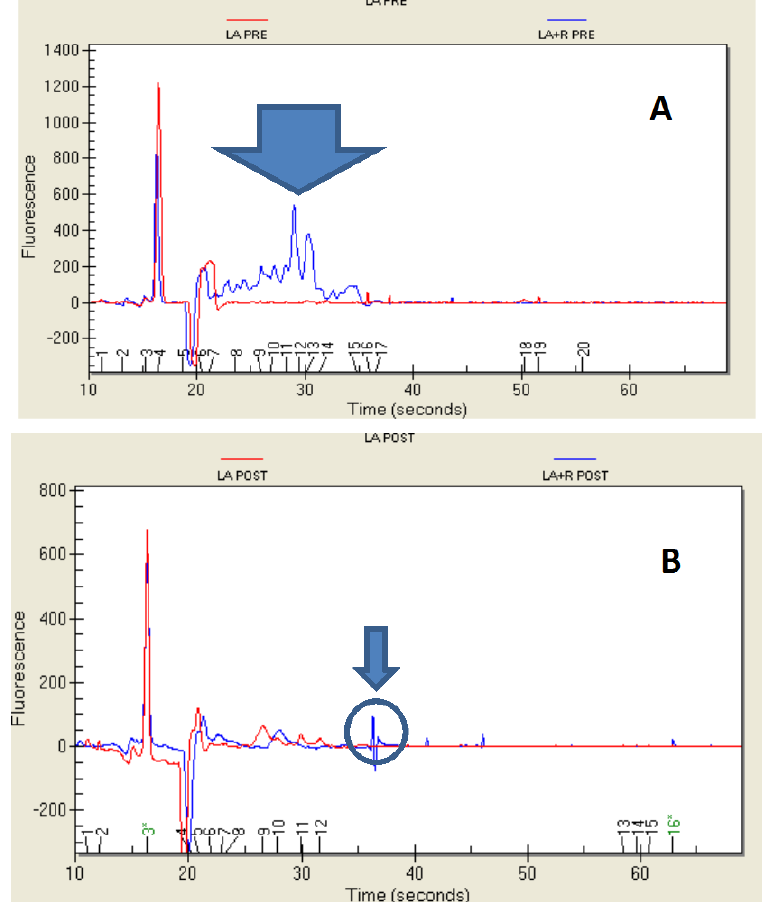
Figure 1. Protein profile (shown as an electropherogram) of Lactobacillus acidophilus , grown in MRS and MRS + E. sativa , before (LA PRE and LA + R PRE) ( A ) and after (LA POST and LA + R POST) ( B ) the in vitro gastro-intestinal